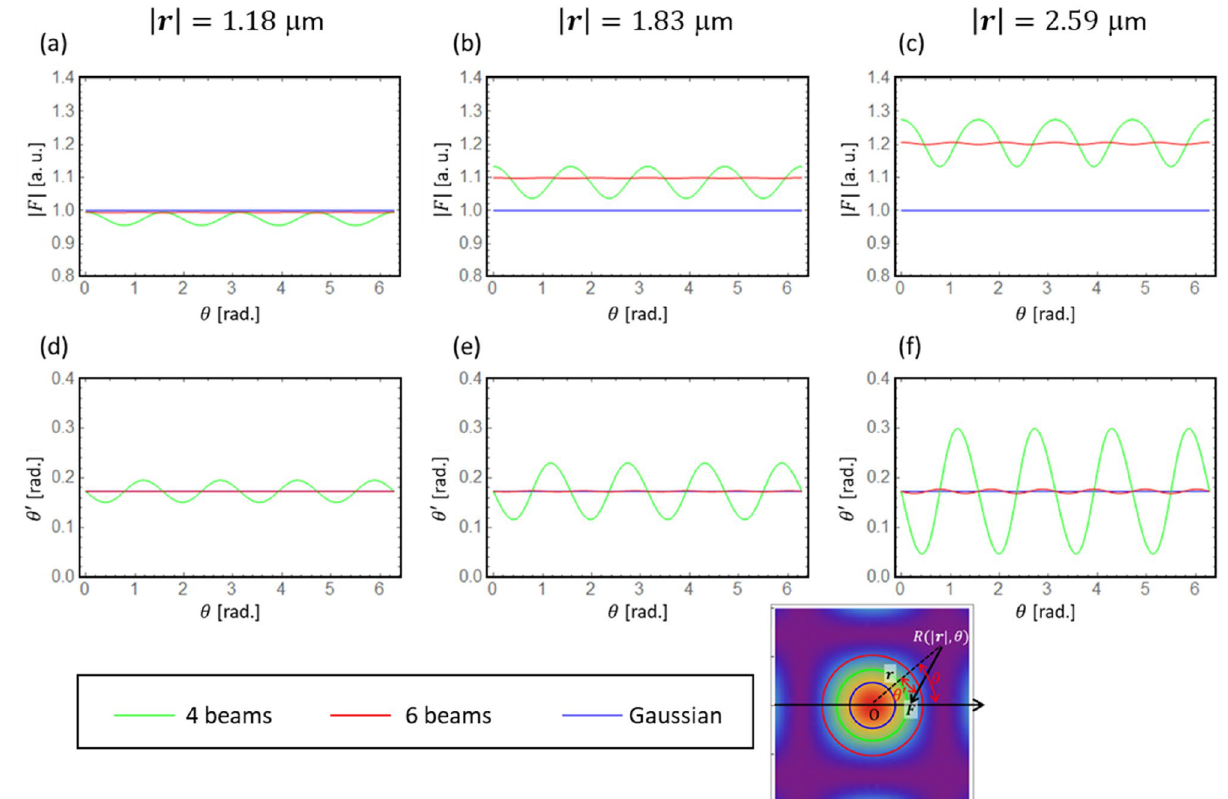
F and ( d – f ) deflection angle θ ′ for different light distribution | |